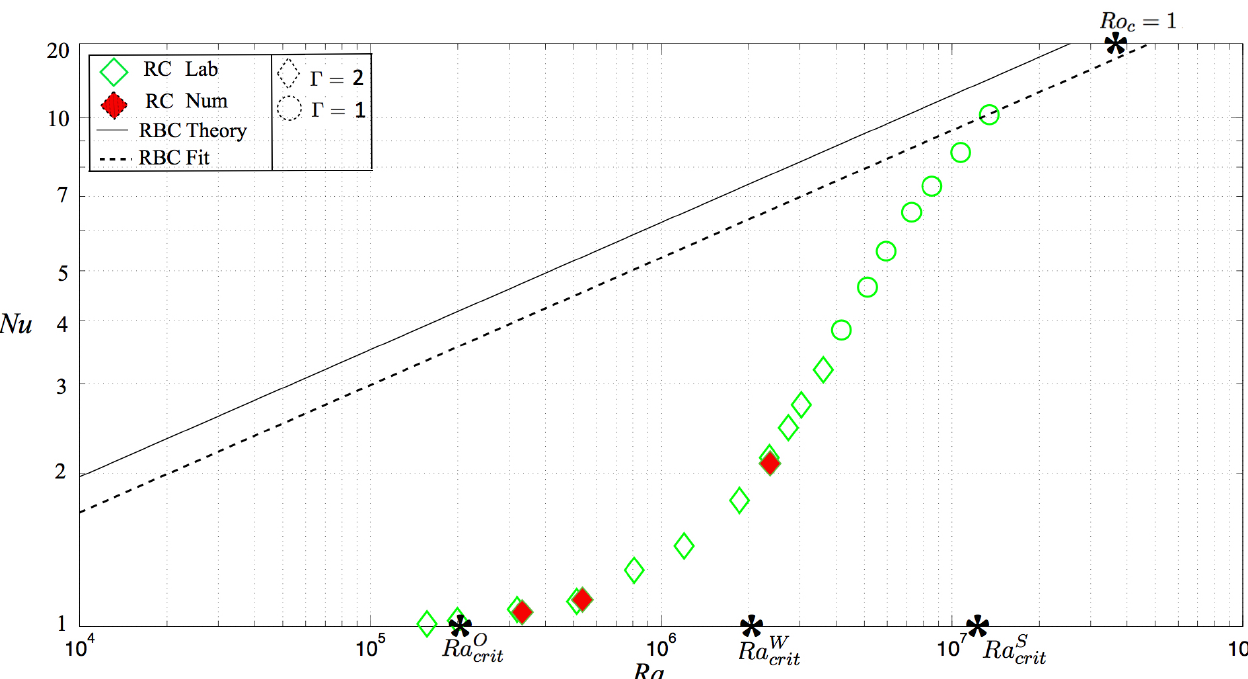
Figure 15. Rotating convection (RC) heat transfer measurements in liquid gallium. Heat transfer efficiency, parameterized by the Nusselt number, Nu , is plotted versus the buoyancy forcing, parameterized by the Rayleigh number, Ra . The Ekman number is fixed at E = 2 × 10 − 5 in these cases. Critical Ra estimates are marked along the bottom horizontal = 1 location is marked on the top axis. axis. The Ro c